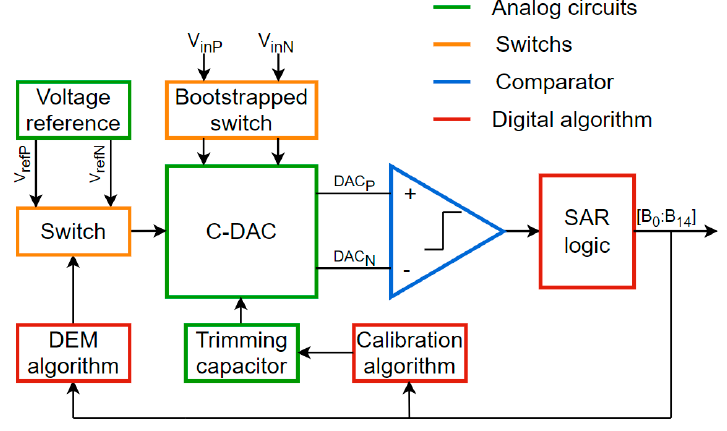
Figure 1. Proposed SAR ADC architecture diagram.